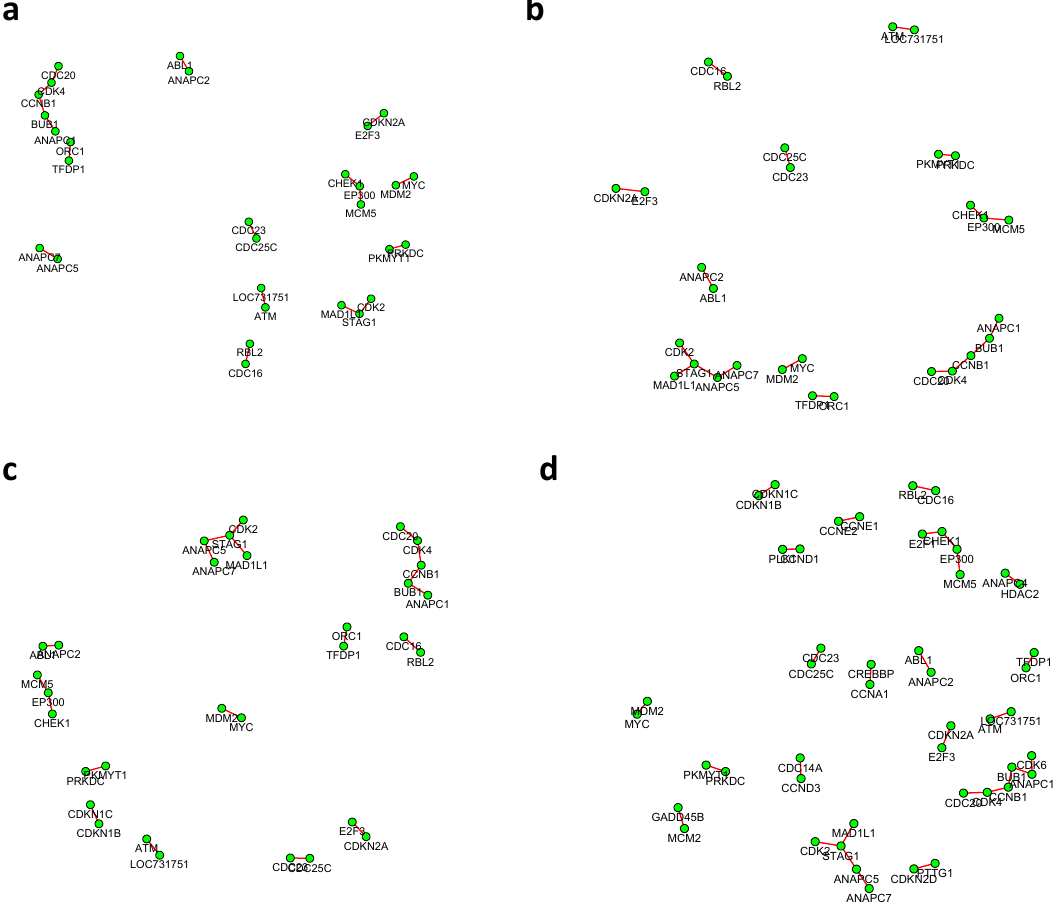
Figure 7. The inferred differential networks between the LumB and Basal-like subtypes under different desired FDR levels: ( a ) 0.05; ( b ) 0.10; ( c ) 0.15; ( d ) 0.20, with all isolated genes being removed. Each connection in the network represents an identified differential